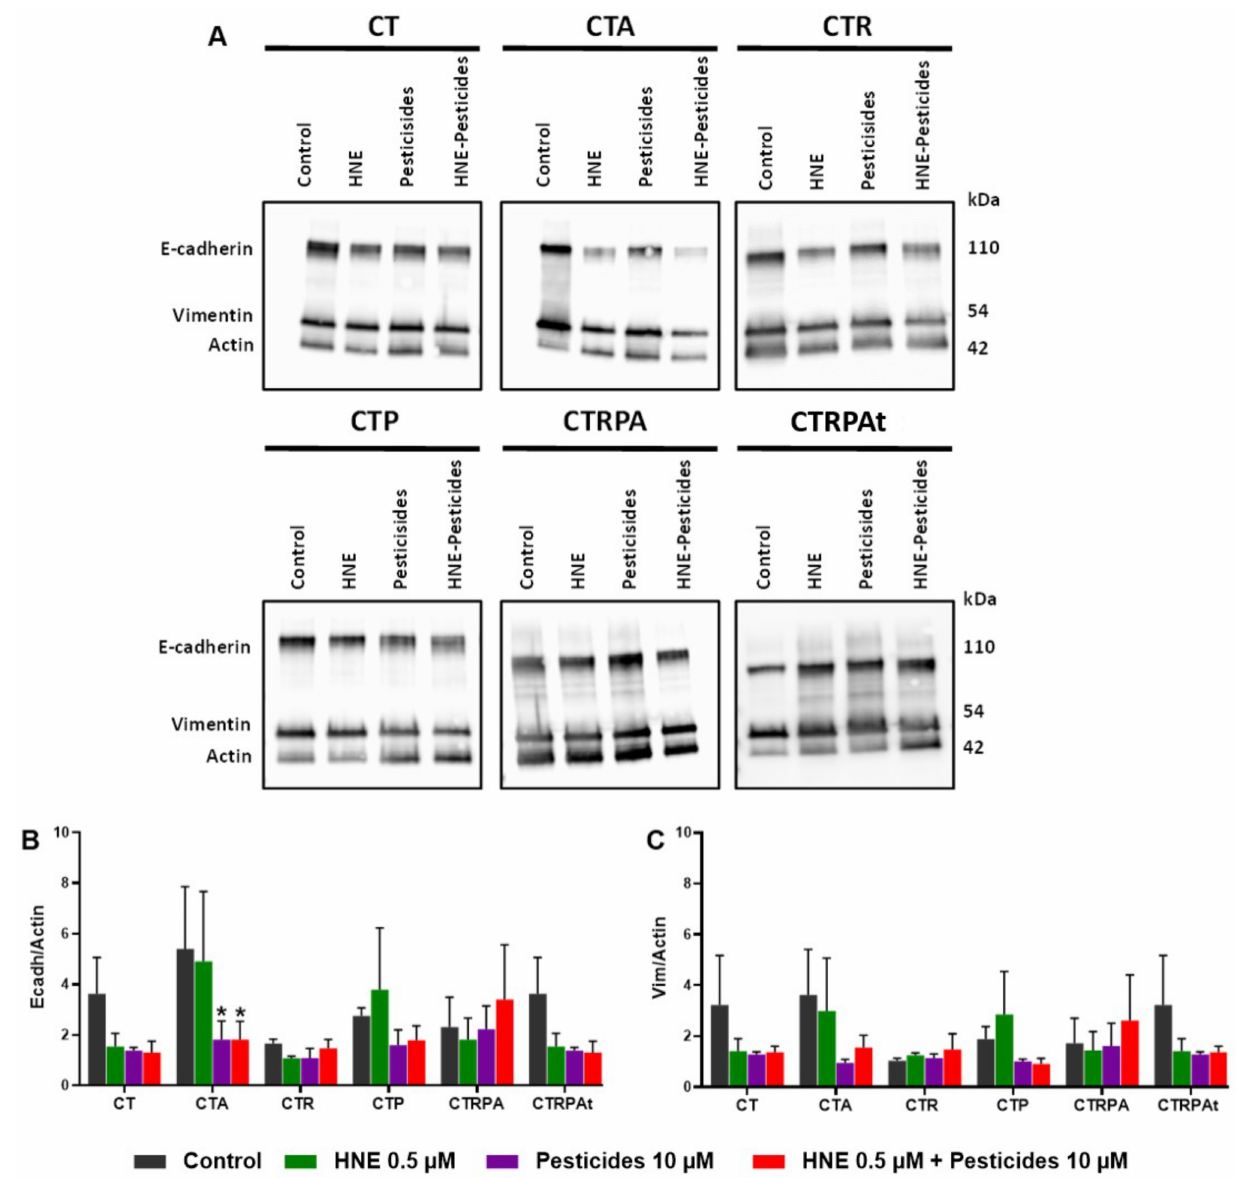
Figure 6. Epithelial-mesenchymal transition (EMT) markers, after three weeks exposure to contaminants in HCECs. ( A ) E- cadherin, Vimentin and Actin immunoblots of soluble extracts. ( B ) Quantification of E-cadherin immunoblots of HCECs relative to actin. ( C ) Quantification of Vimentin immunoblots of HCECs relative to actin. All the results ( B , C ) represent the mean ± SEM of three independent experiments; statistical differences were analysed by post-hoc tests of a 2-way ANOVA model between control and treated cells (* p <